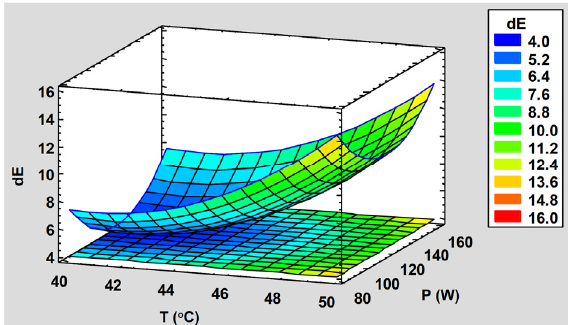
Figure 22. Effect of T and P on color change dE.